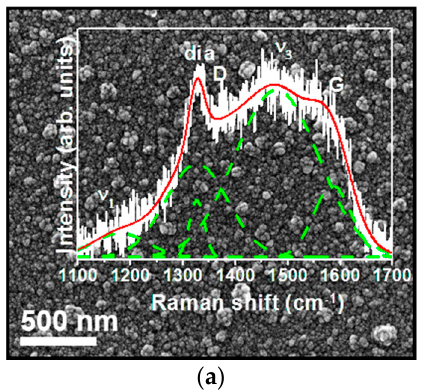
and a broadened peak at around 1360 cm − 1 (D-band) corresponds to disordered carbon. The G-band